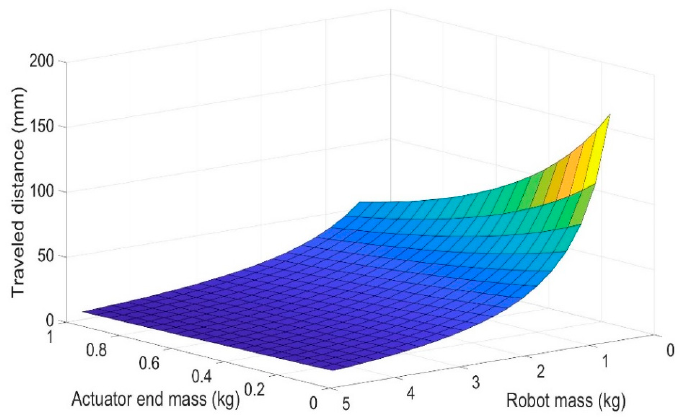
Figure 9 . Correlation between the mass of the robot, actuator end mass, and the travelled distance . Further, the influence of the friction force is shown in Figure 10. On the z axis, the trav- elled distance of the robot can be seen. On the y axis, the friction force is in the backward di- rection, meaning the robot would go down. On the x axis, the friction force is in forward di- rection, meaning the robot would go up. The force on the y axis is displayed in N and the force on the x axis is displayed in the percentage of the friction force in the backward direction.